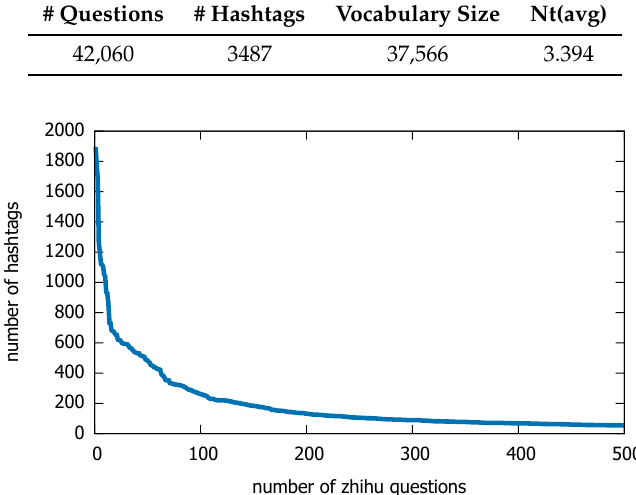
Table 2. Statistics of the dataset, Nt(avg) is the average number of hashtags in the Zhihu dataset.